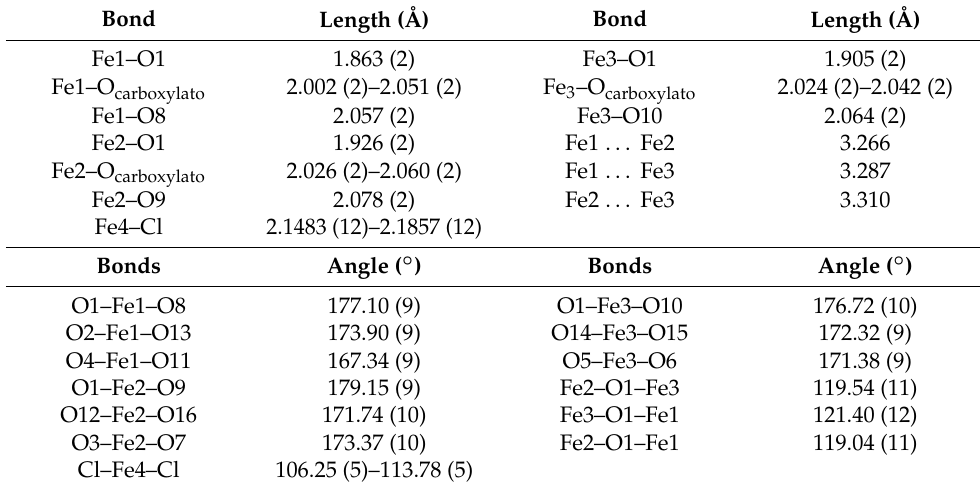
Table 3. Selected structural features (bond lengths (Å) and bond angles ( ◦ )) for complex 3